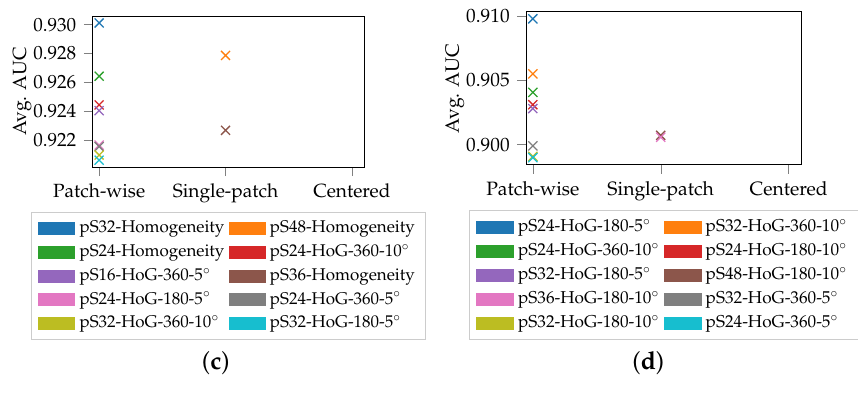
Figure 11. Average AUC calculated over S060, S080/S050-uniaxial strain and S110/S100-near plane strain: ( a ) DX54D (2.00 mm). ( b ) DP800. ( c ) DX54D (0.75 mm). ( d ) AC170.